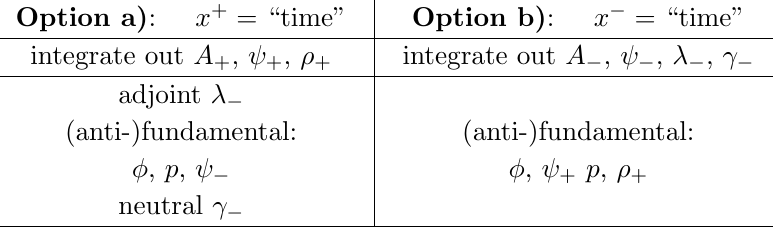
Table 2 . SU( N c ) representations of SQCD partons with di(cid:11)erent choices of the light-cone time. in the basis of colorless states. We are going to (cid:12)nd masses of states in the